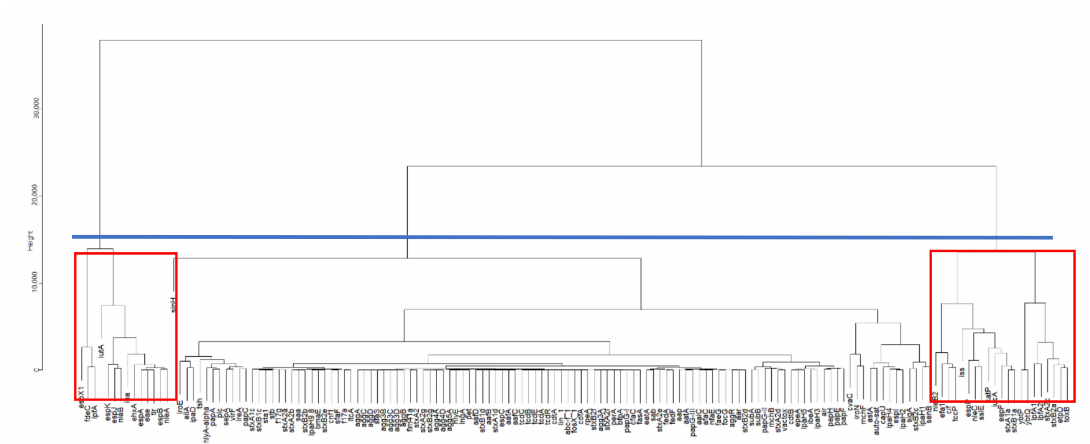
Figure 2. The result of hierarchical clusters of virulence genes in the US. The blue line indicates how the six clusters were obtained. The two red rectangles highlight the clusters containing the outlier genes, which are typically the highest branches in the dendrogram and regarded as important virulence genes identified in the US.